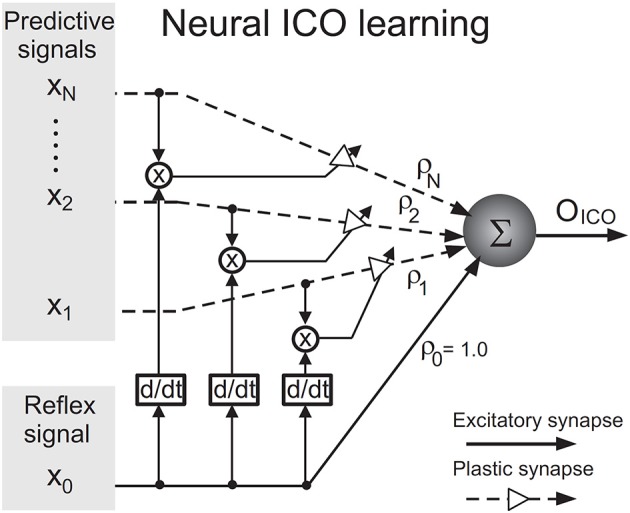
Neural circuit for input correlation learning (taken from Manoonpong et al., 2013).